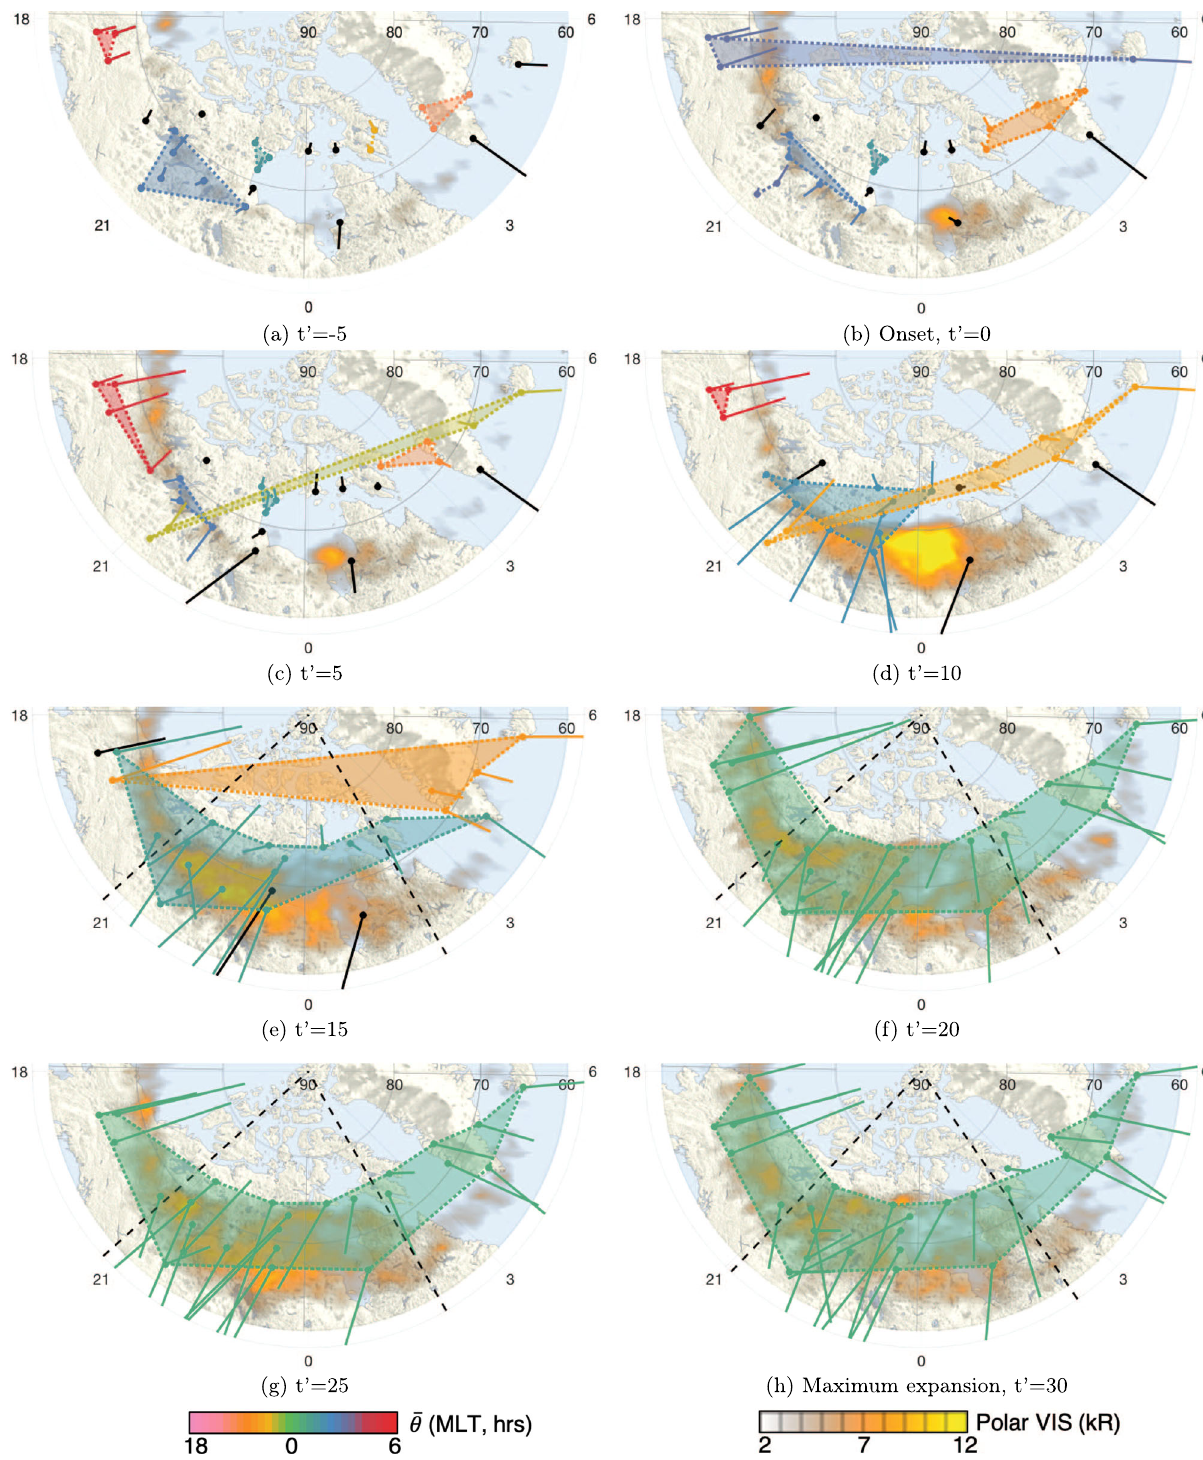
Fig. 2 Community structure snapshots of an example substorm in normalized time, t 0 . Polar plots are in magnetic coordinates centered at the magnetic pole, where magnetic local time (MLT, h) increases clockwise, with midnight located at the bottom (MLT = 0 h). Maps show the nightside from dusk (MLT = 18 h) to dawn (MLT = 6 h) and 60 – 90° magnetic latitude. Plotted are the magnetic fi eld perturbation vectors (North and East components, B N , E , measured in nT) for a substorm on 16/03/1997. The colorbars at the bottom of the fi gure represent the MLT of the centroid ( (cid:1) θ ð t 0 Þ ) of each community, and polar VIS data from left to right, respectively. The vectors are color-coded using the left and match those of c , d in Fig. 1. Each subplot ( a – h ) represents a snapshot of the community structure in intervals of fi ve normalized minutes from before onset ( a , t 0 ¼ (cid:2) 5) to the time of maximum expansion ( h , t 0 ¼ 30), corresponding to the times in Fig. 1. The circles represent ground magnetometers with the line representing the B N , E vector. Black magnetometers are not part of a community. The dashed lines are the locations of the auroral bulge found from auroral images. The vectors are overplotted on maps provided by superMAG 2 containing polar VIS data 28 in kR, matching the right